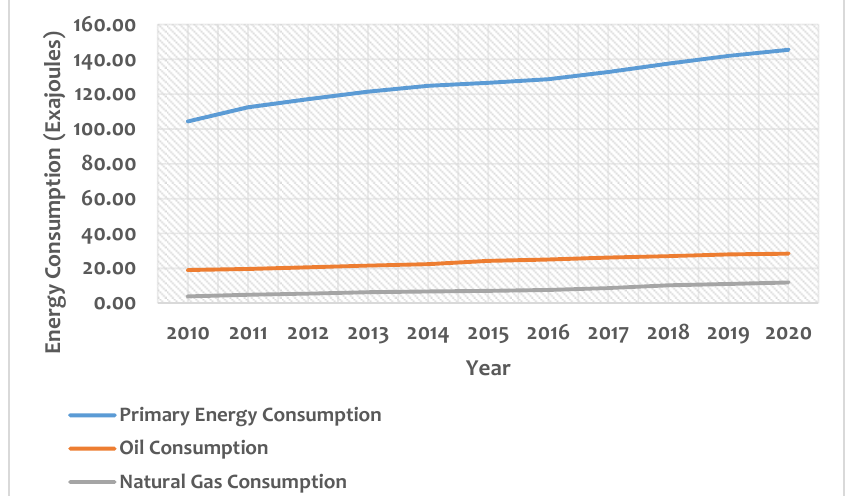
Figure 5. Chinese energy consumption based on data from [4].